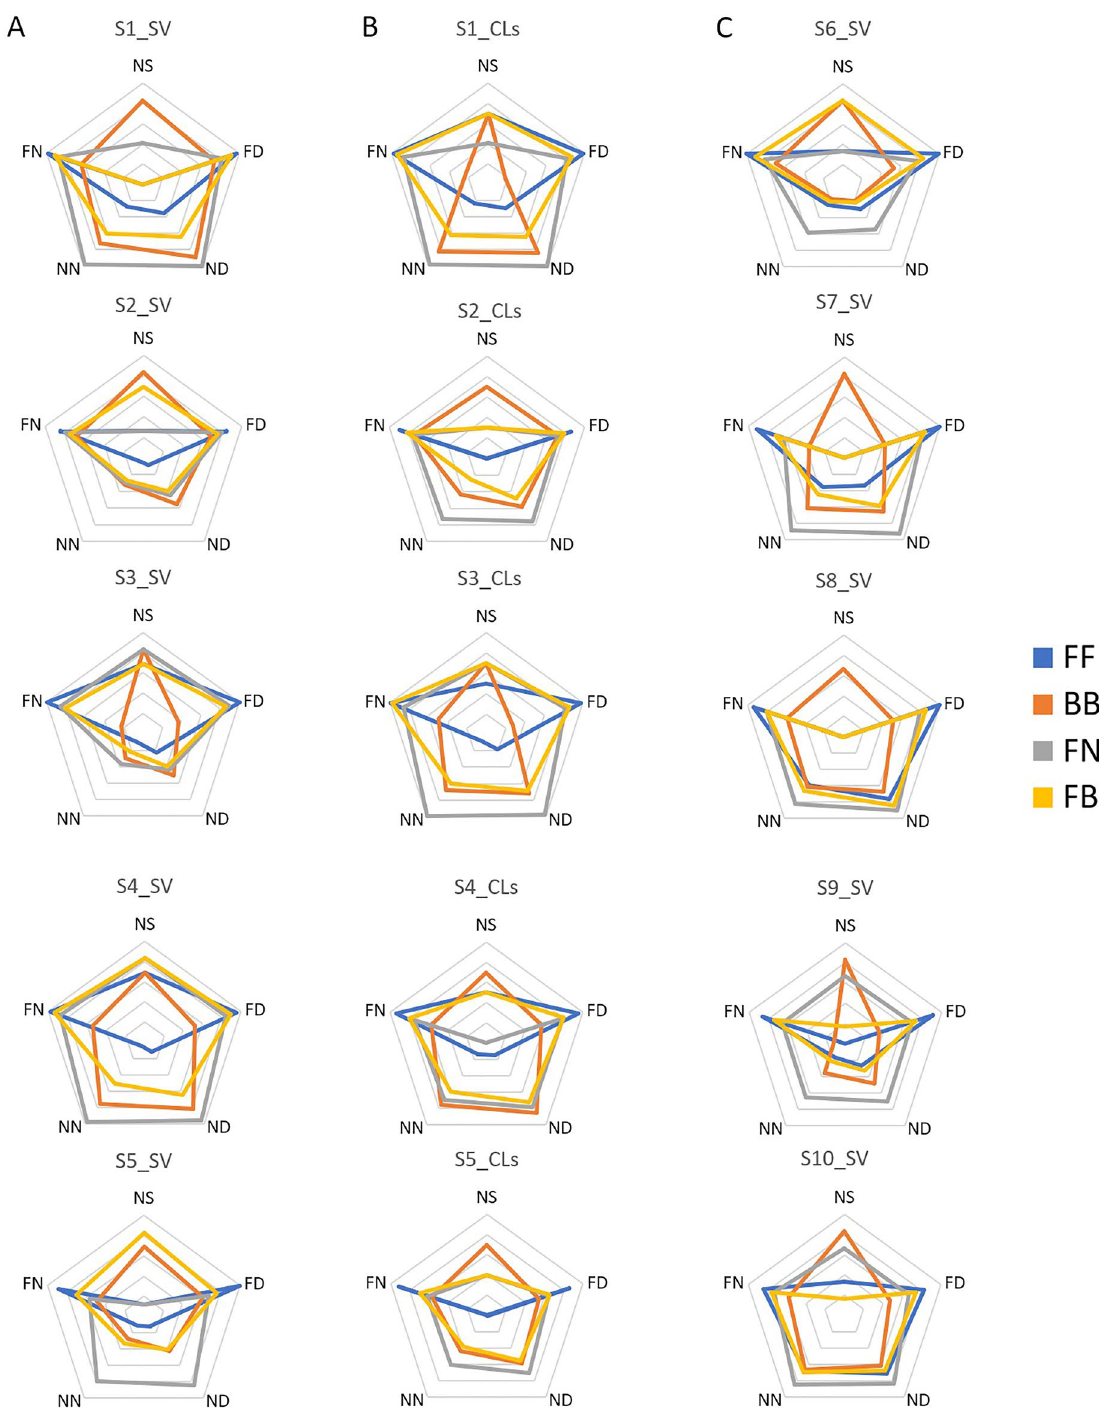
Figure 4. MAS-2EV polygons. ( A ) For young subjects measured with SimVis. ( B ) For young subjects measured with CLs. ( C ) For presbyopic subjects measured with SimVis. Blue line corresponds to bilateral monofocal correction for far (FF), orange line to bilateral bifocal (BB), gray line to monovision (FN), and yellow line to modified monovision